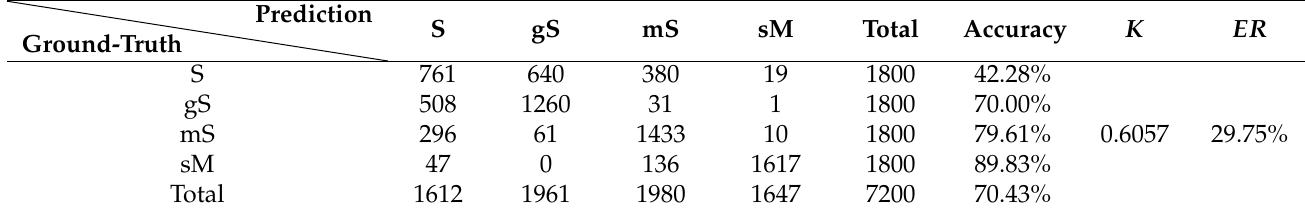
Table 3. Classification results of the Random Forest model using Gray Level Co-occurrence Matrices features. Ground-Truth